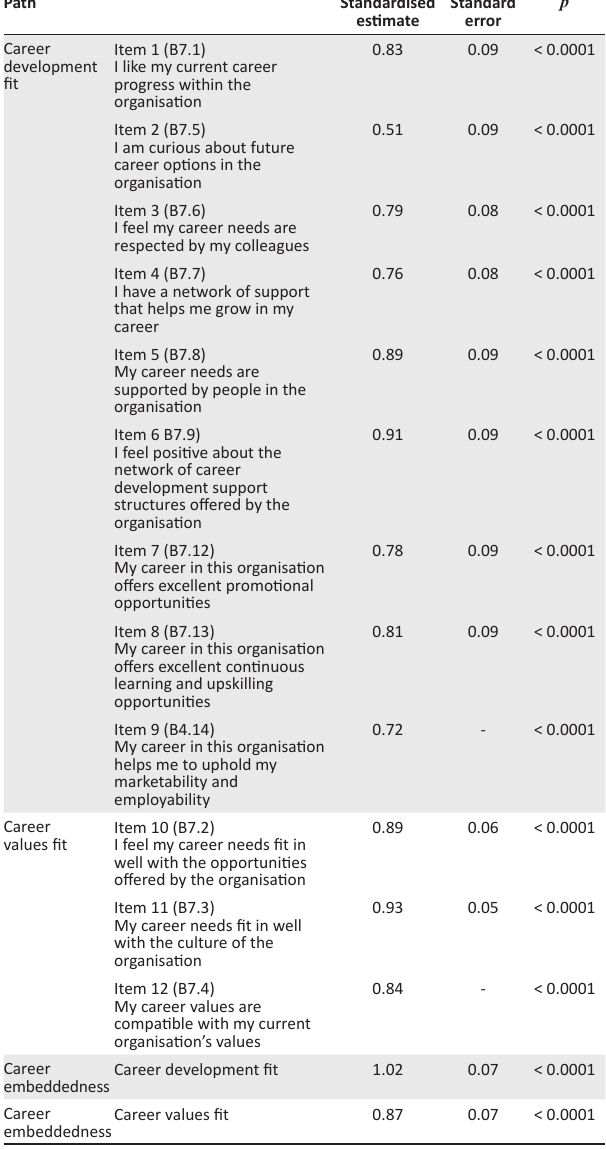
TABLE 3: Standardised path coefficients of the career embeddedness scale. Path